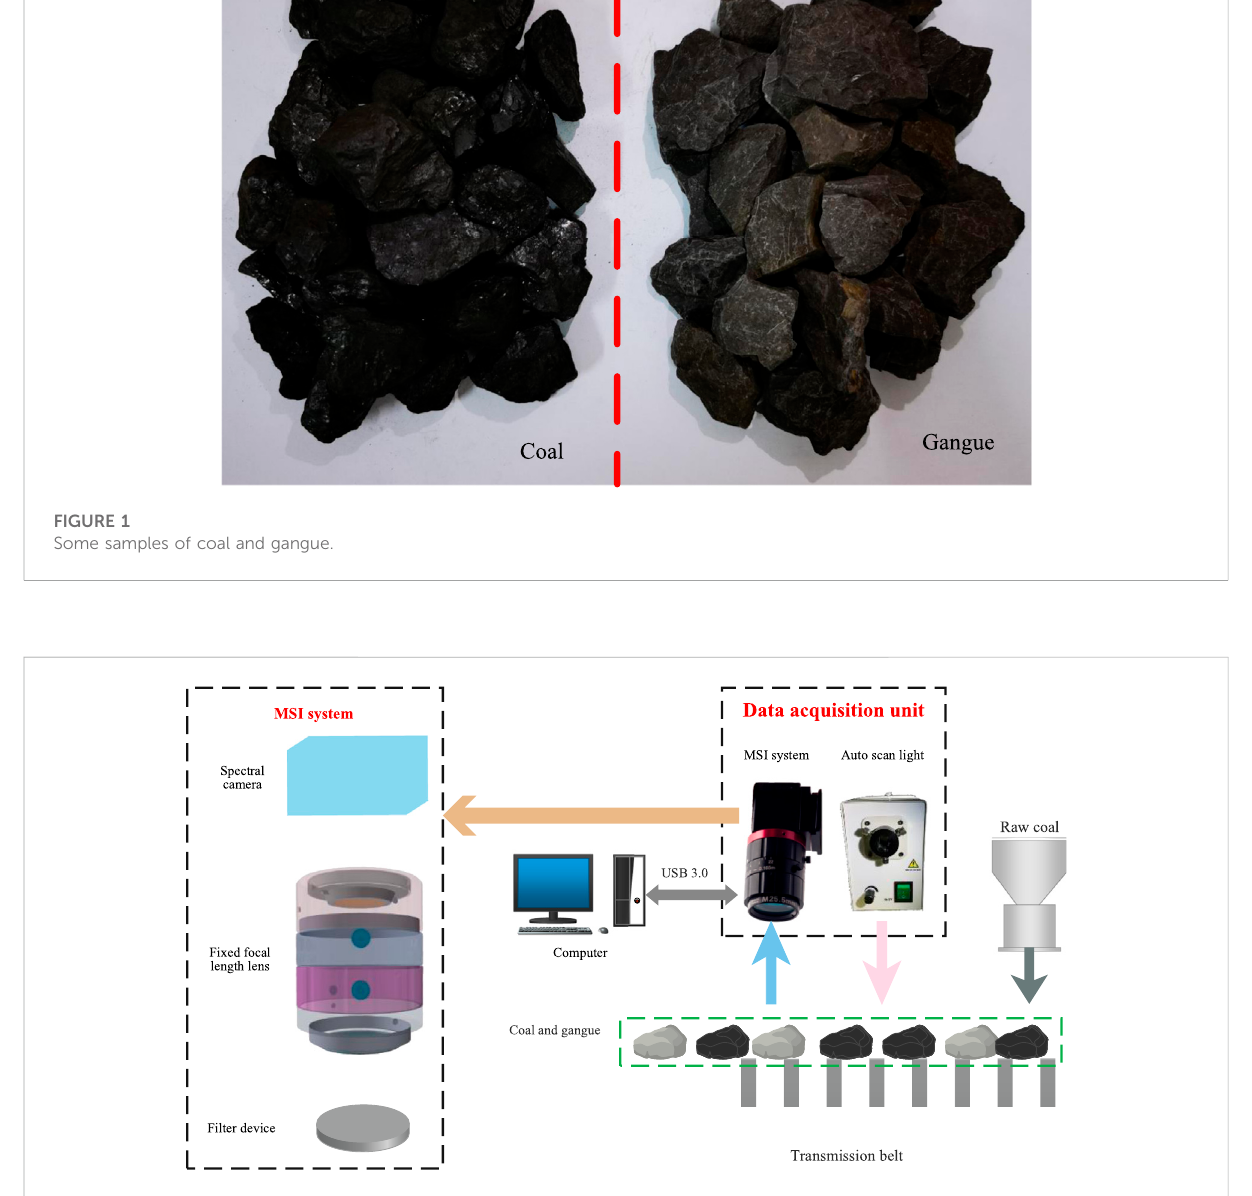
FIGURE 2 Schematic diagram of the multispectral acquisition